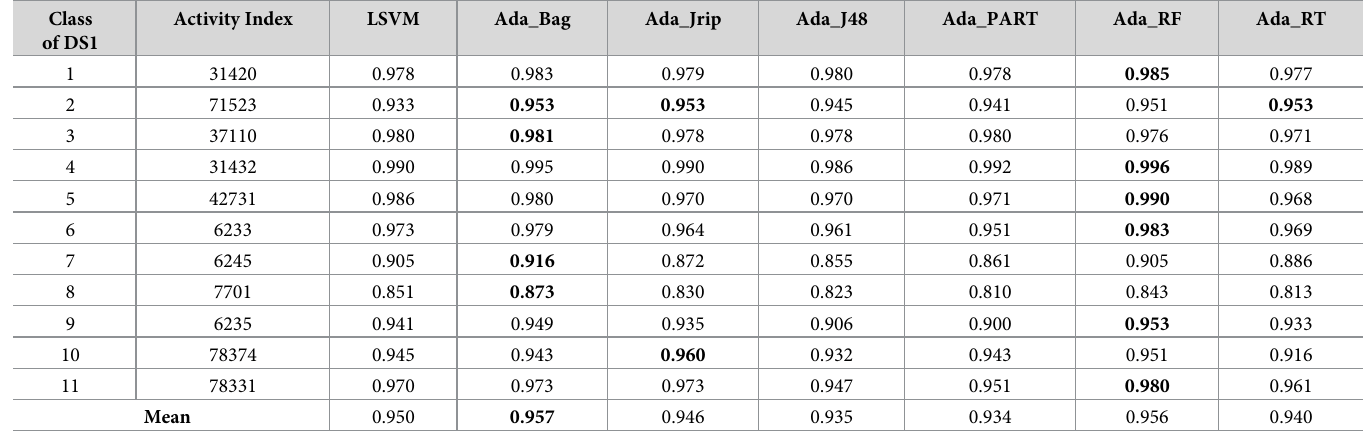
Table 4. Sensitivity measure for the prediction of new bioactive molecules with DS1 (normal